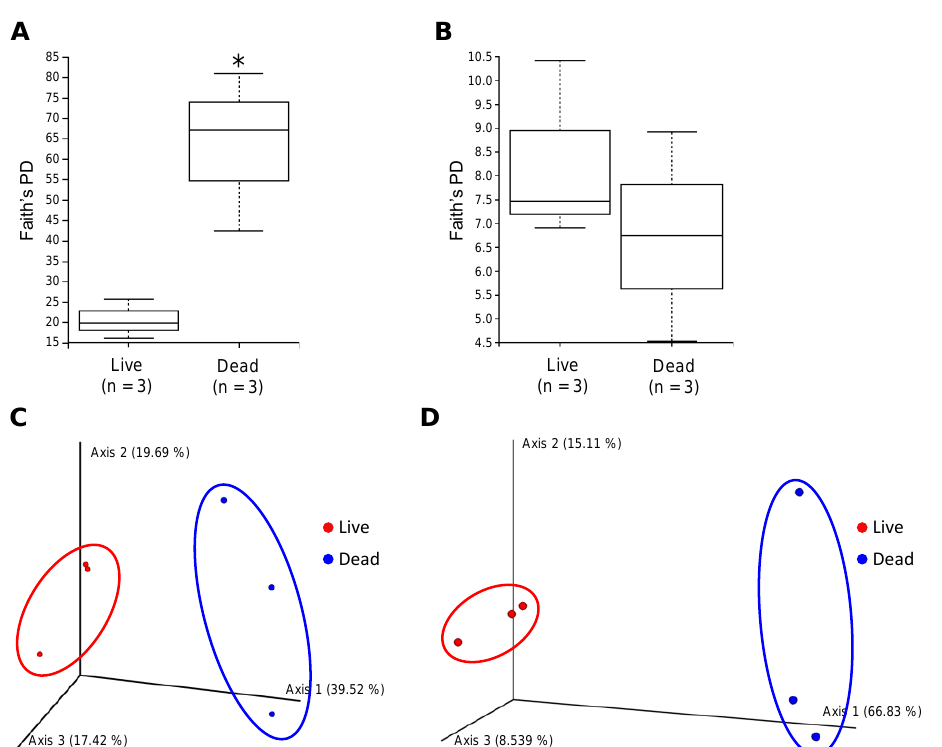
Figure 2. Alpha and beta diversity comparisons of microbial and fungal communities from live and dead trees. ( A , B ) Faith’s Phylogenetic Diversity (PD) of the bacterial ( A ) and fungal ( B ) communities from live and dead Korean fir trees. Boxes represent the interquartile range (IQR) of 25th to 75th percentiles. The median value is shown as a horizontal line within the box. Whiskers represent the most extreme value within 1.5 times the IQR. Statistical analyses were carried out using a pairwise Kruskal–Wallis test relative to the Live trees (* p < 0.05). ( C , D ) Principal Coordinate Analysis (PCoA) plot using Bray–Curtis distance matrix on bacterial ( C ) and fungal ( D ) communities from live (Red circles) and dead (Blue circles) Korean fir trees.